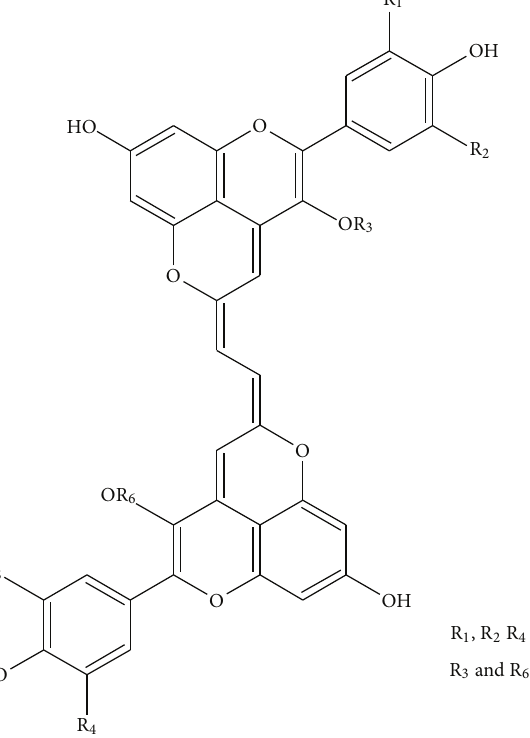
F 13: Hypothetic general structure for dimers detected in wine and lees